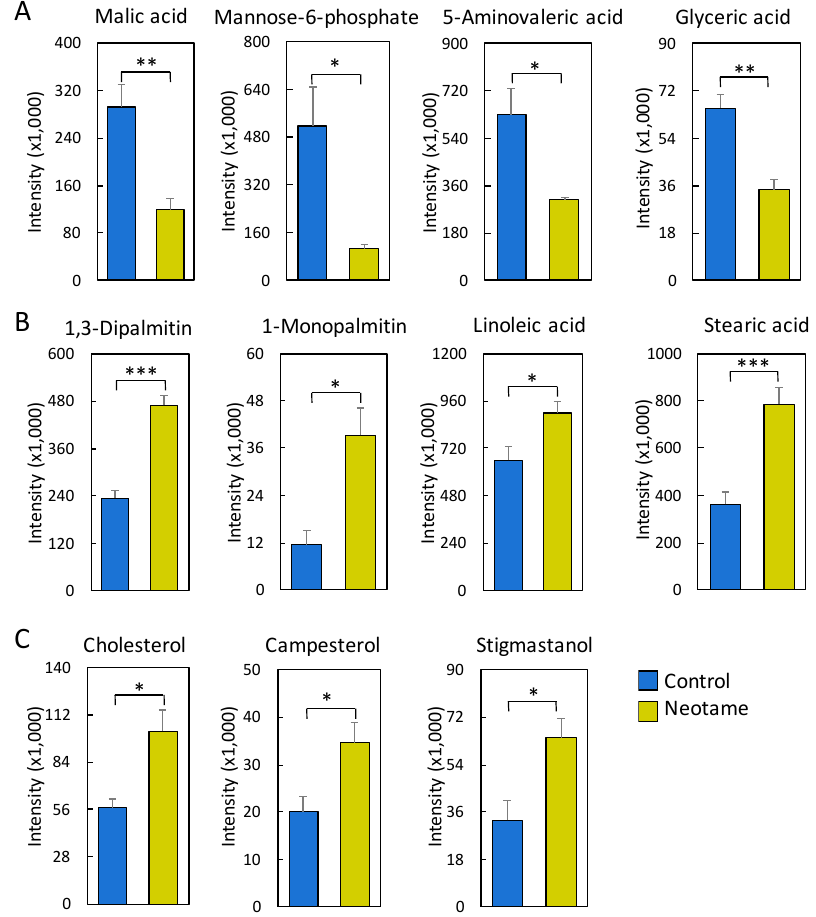
Figure 5. ( A ) Malic acid, mannose-6-phosphate, 5-aminovaleric acid and glyceric acid are significantly reduced in the fecal samples of neotame-treated mice; ( B ) Multiple fatty acids and lipids are significantly increased in the fecal samples of neotame-treated mice; ( C ) Cholesterol, campesterol and stigmastanol are significantly increased in the fecal samples of neotame-treated mice. (* p < 0.05; ** p < 0.01; *** p < 0.001).